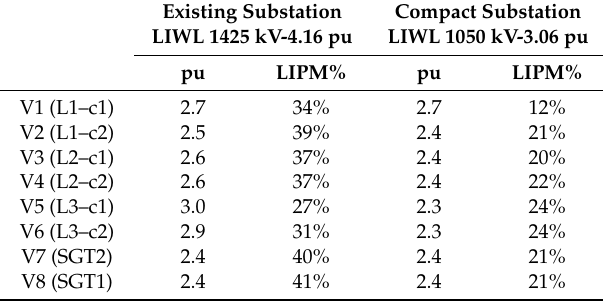
Table 6. Lightning overvoltages for existing and compact substations with surge arresters; Residual margin in